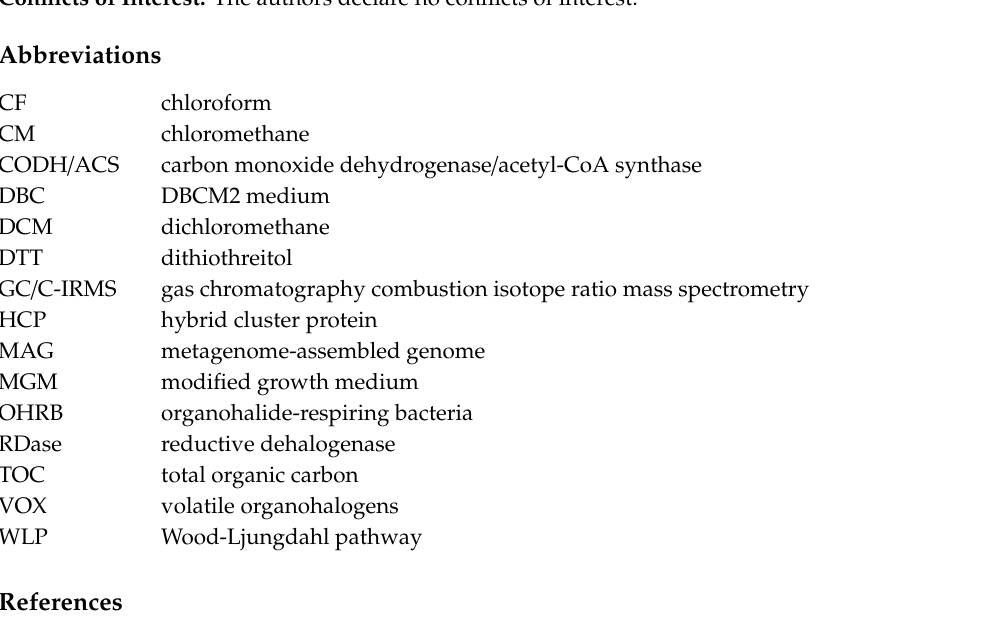
Table S2: Primers used in this study, Table S3: Overview of metagenomic reads not mapped to the metagenome assembled-genomes (MAGs), Table S4: Features of the MAGs, Table S5: Taxonomic classification of the MAGs, Table S6. Name of the genes and encoded proteins in Figures 4 and